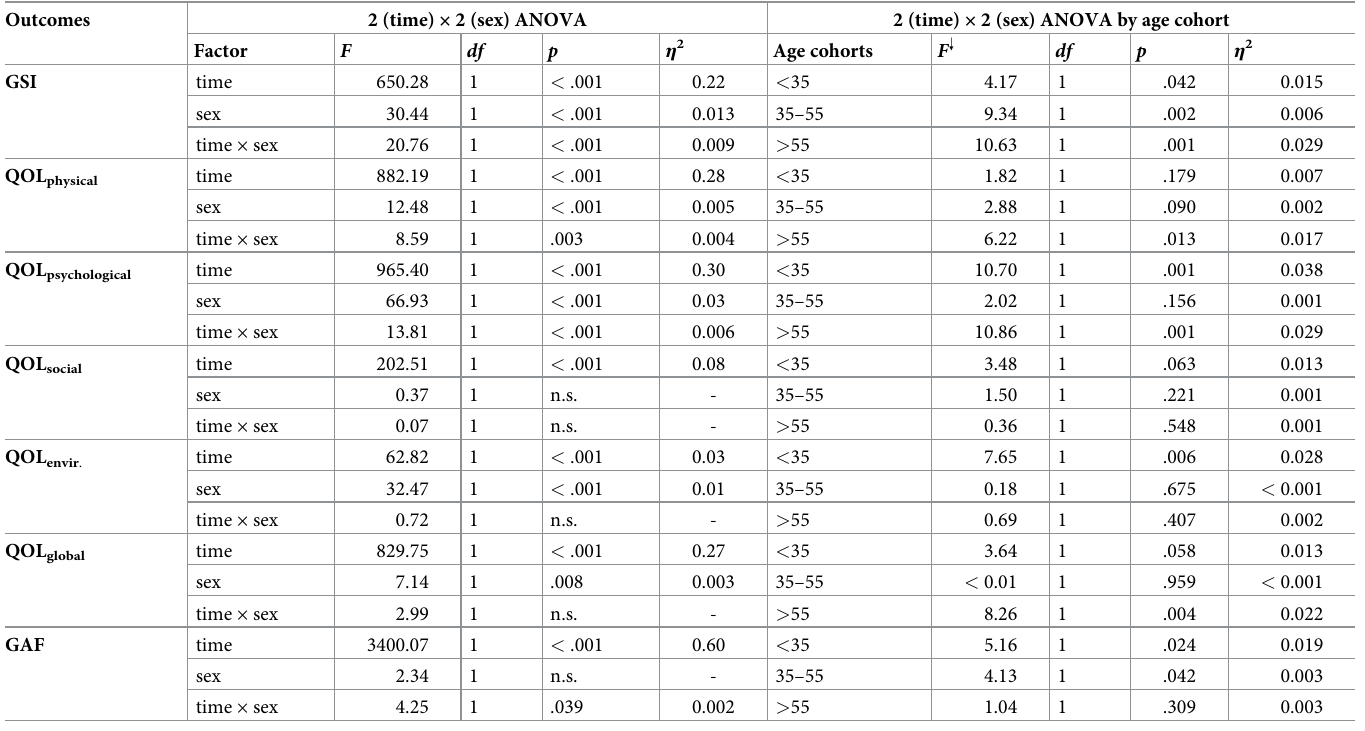
Table 4. Group comparison in the improvement of the outcomes of admission and discharge surveys (T1—T2).